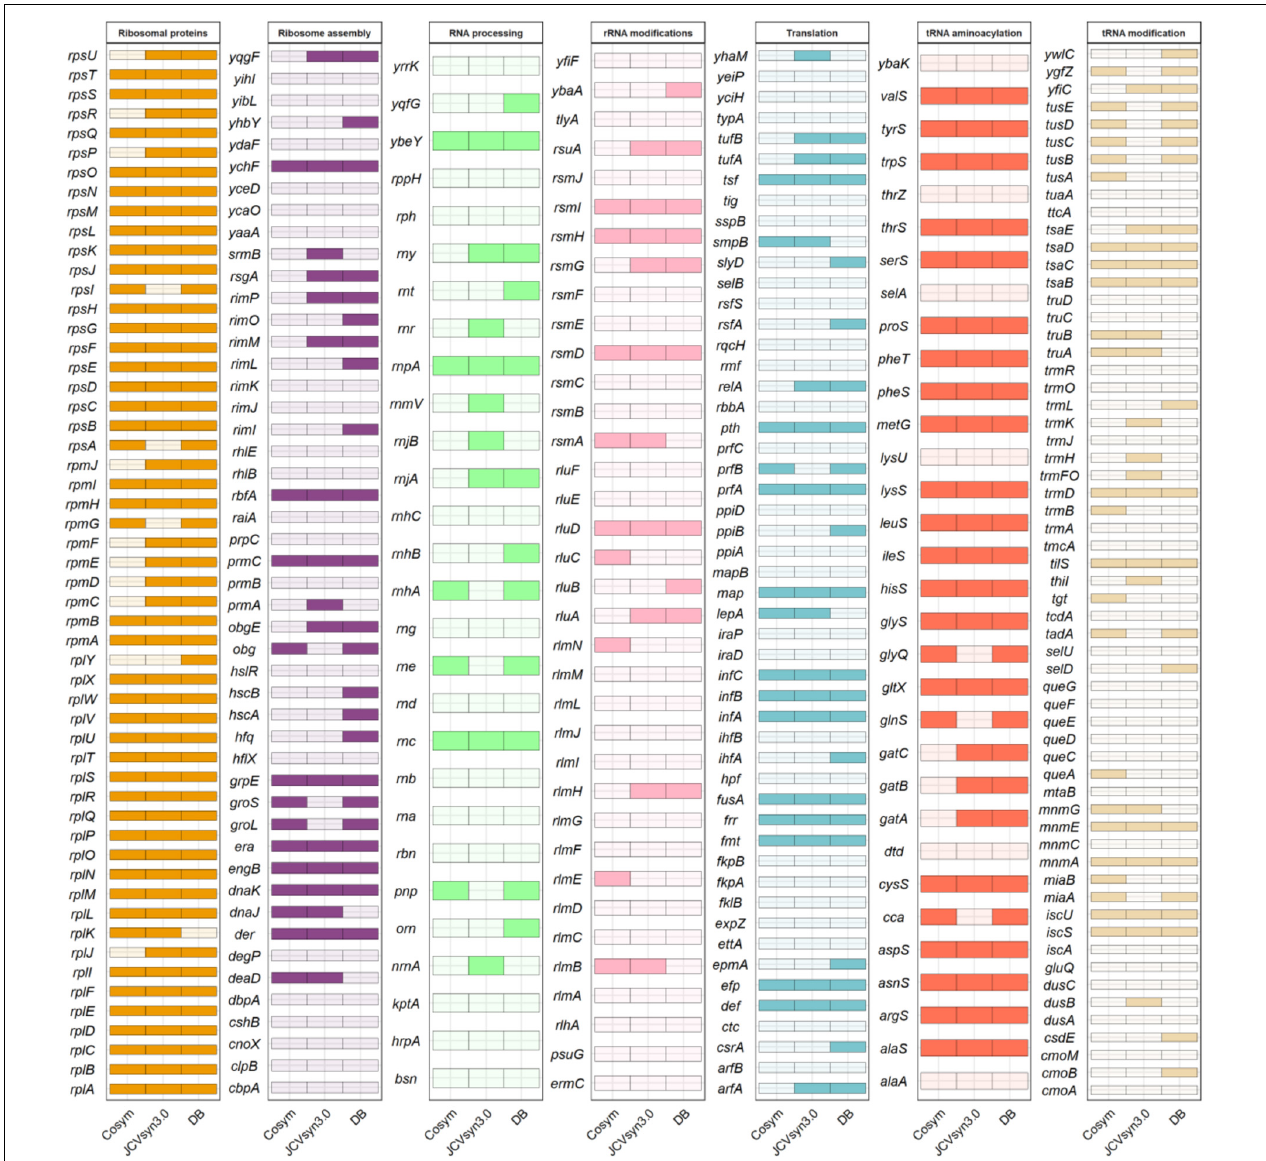
FIGURE 3 | Comparison of translational genes in DataBases [bacterial gene list of essential translational genes for Escherichia coli K-12 MG1655 and Bacillus subtilis 168, obtained from the Database of Essential Genes, Subtiwiki, Goodall et al. (2020) and Koo et al. (2017)], cosym (dataset of candidate genes included in our preliminary proposal of a minimal translational machinery obtained from endosymbiont genomes by HCA in this work) and JCVI-syn3.0 (dataset of genes annotated in this genome as involved in